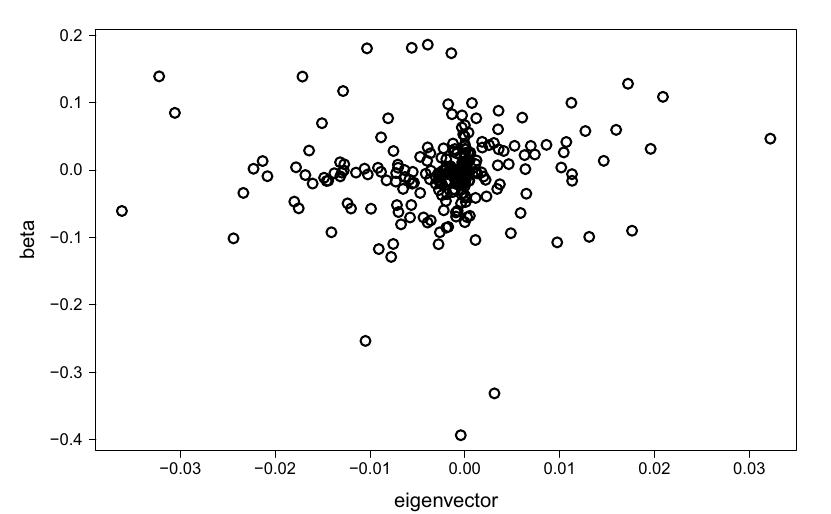
Figure 6. Scatter plot of β and the eigenvector corresponding to the maximum eigenvalue of (cid:31) 2 . The nonzero elements of β are not